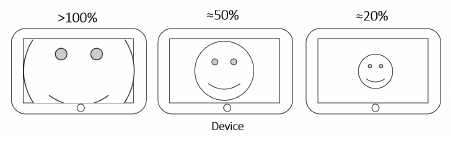
Figure 4. The example of effective